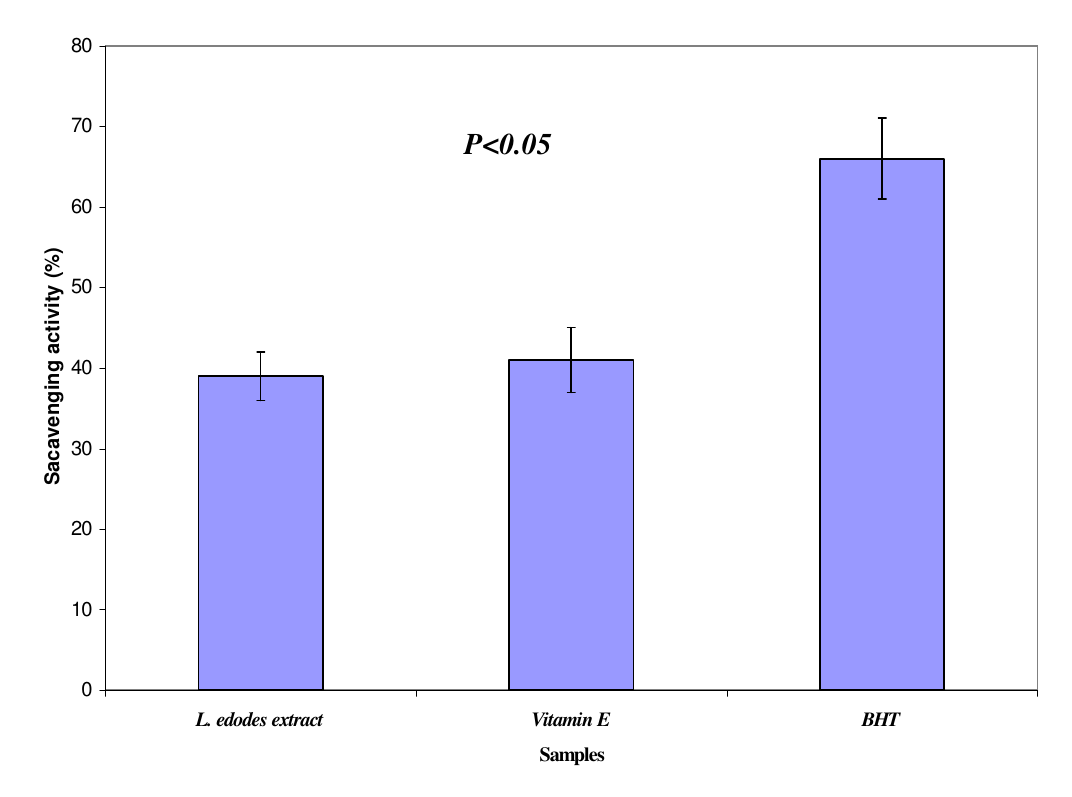
Figure 1. Scavenging effect (%) of crude extract of Lentinula edodes, and the known antioxidants BHT and vitamin E at 1.0 mg/mL.